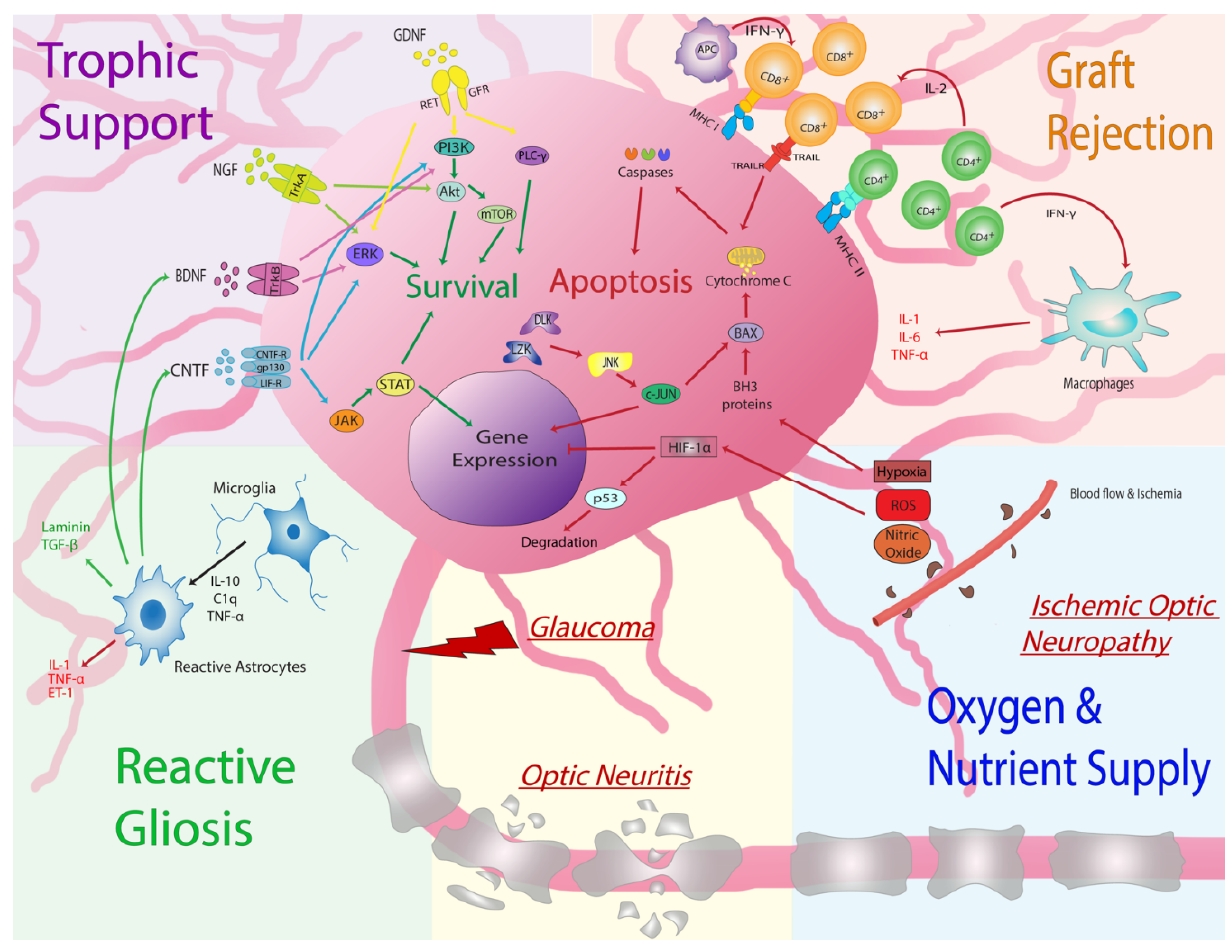
Figure 2. Cell intrinsic and environmental processes and signaling pathways regulating RGC survival following transplantation. Akt—protein kinase B; BAX—bcl-2-like protein 4; APC—antigen presenting cell; BDNF—brain derived neurotrophic factor; C—complement; CD—cluster of differentiation; CNTF—ciliary neurotrophic factor; DLK—dual leucine zipper kinase; ERK—extracellular signal-regulated kinase; ET—endothelin; GDNF—glial derived neurotrophic factor; GFR—GDNF family receptor; gp130—Glycoprotein 130 receptor; HIF—hypoxia inducible factor; IFN— interferon; IL—interleukin; JAK—Janus kinase; JNK—c-Jun-N-terminal kinase; LIF—leukemia inhibitor factor; LZK—leucine zipper kinase; MHC—major histocompatibility complex; NGF—nerve growth factor; p53—transformation-related protein 53; PI3K—phosphoinositide 3-kinase; PLC—phospholipase C; mTOR—mammalian target of rapamycin; RET—rearranged during transfection receptor; ROS—reactive oxygen species; STAT—signal transducer and activator of transcription proteins; TNF—tumor necrosis factor; Trk—tropomyosin receptor kinase.